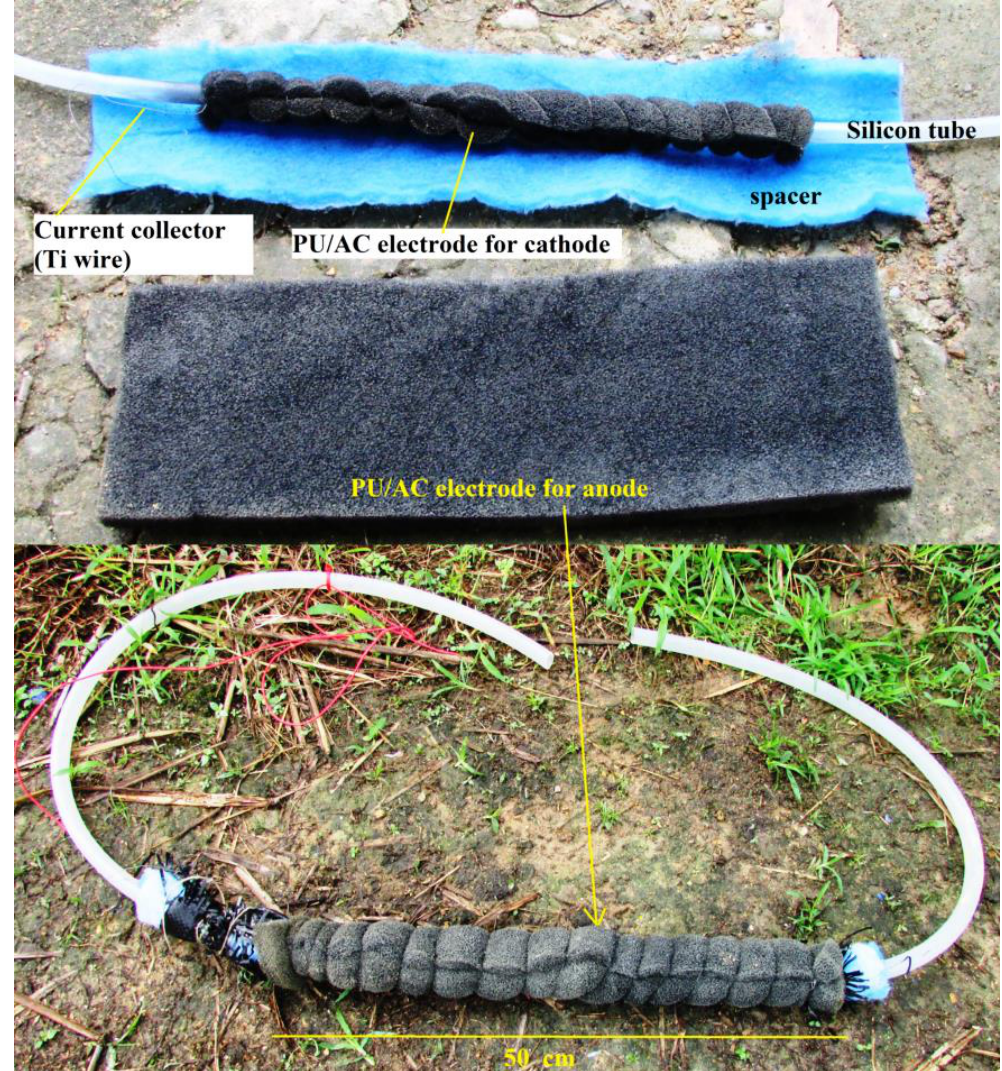
Figure 3. Materials and completely constructed tubular Plant-MFC with PU/AC